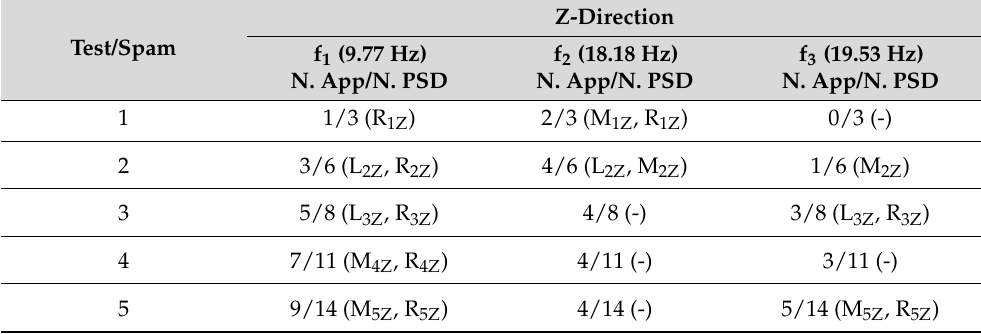
Table 4. Number of appearances varying the number of tests: Z-direction.